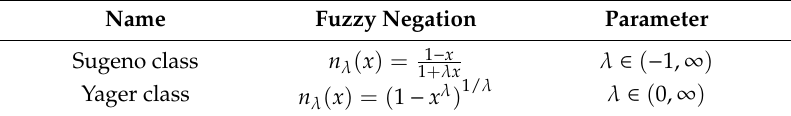
Table 2, proposes two parametric families of fuzzy negations: Table 2. In ref. [32] Fuzzy